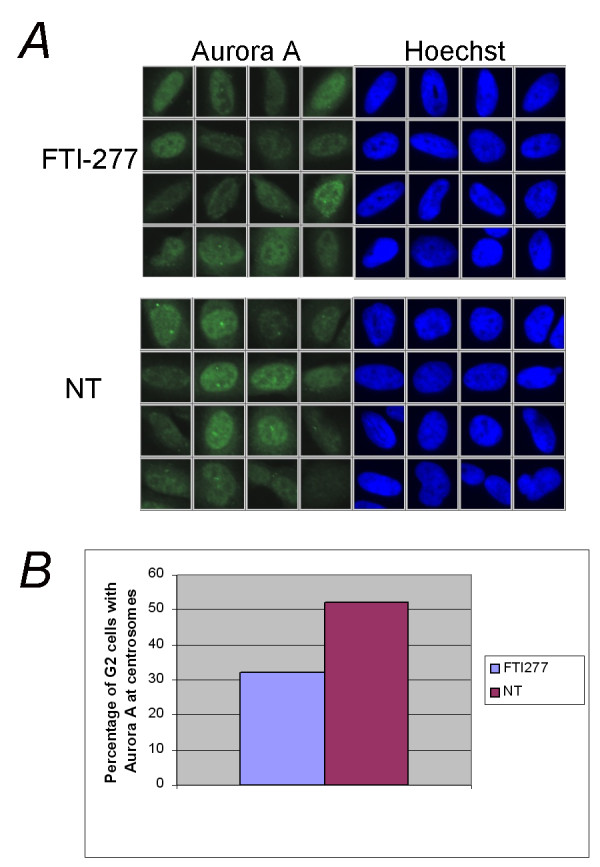
FTI treatment impairs the localization of Aurora A in G2-M cells. HeLa cells were seeded in 10 wells of a 96-well plate and grown as indicated in Methods. After 48 hours treatment with 2 μM FTI-277 (FTI-277) or no treatment (NT), the cells were fixed and stained with an antibody recognising aurora A (αIAK1; BD Biosciences) and the cell cycle distribution was calculated based on the total intensity signal in the Hoechst channel within the nuclear area using the ScanR analysis software. Ten wells were considered per sample and 12 images were acquired randomly in each well. A, Representative cells falling within the G2/M gate of treated (FTI-277) or untreated (NT) HeLa cells. B, The graph shows the percentage of G2/M phase cells that have Aurora A localized in spots at centrosomes in FTI-277-treated cells and in untreated cells. Two hundred randomly chosen cells were counted for each condition.